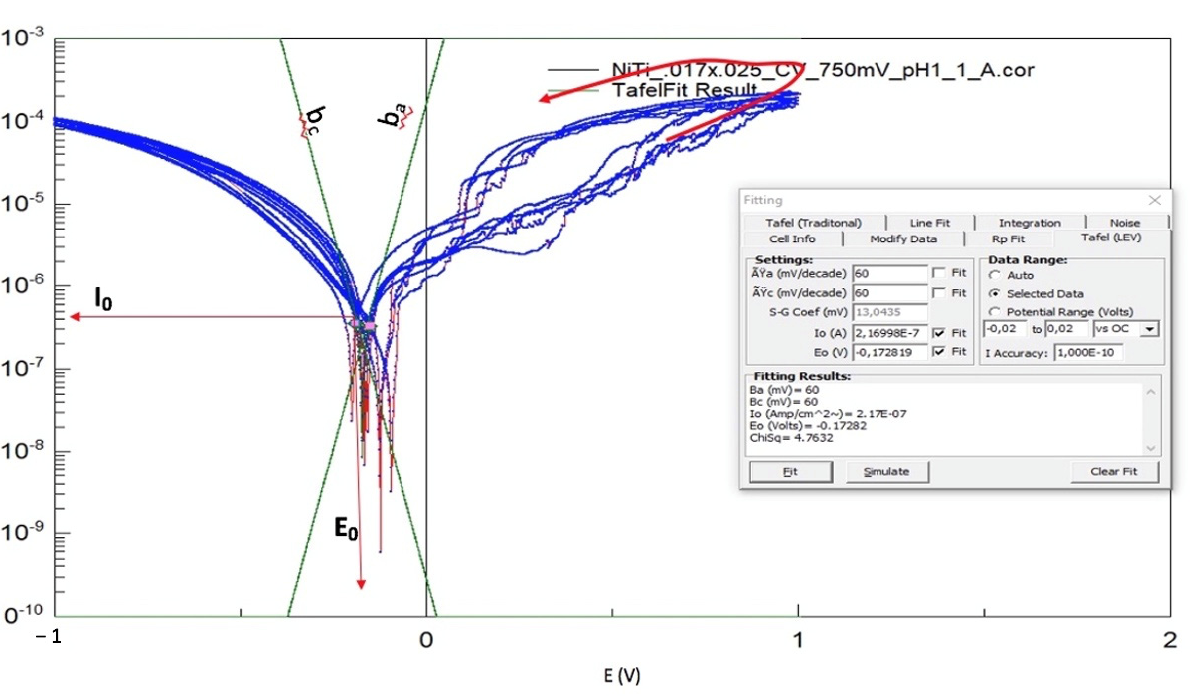
Figure 4. A cyclic voltammogram Log(i) versus E curves for NiTi wire showing the analysis window of CorrView 3.0 to estimate polarization resistance (Rp), corrosion current density (icorr) (corrosion current density (I 0 ) values are marked in red), and corrosion potential (E 0 ).